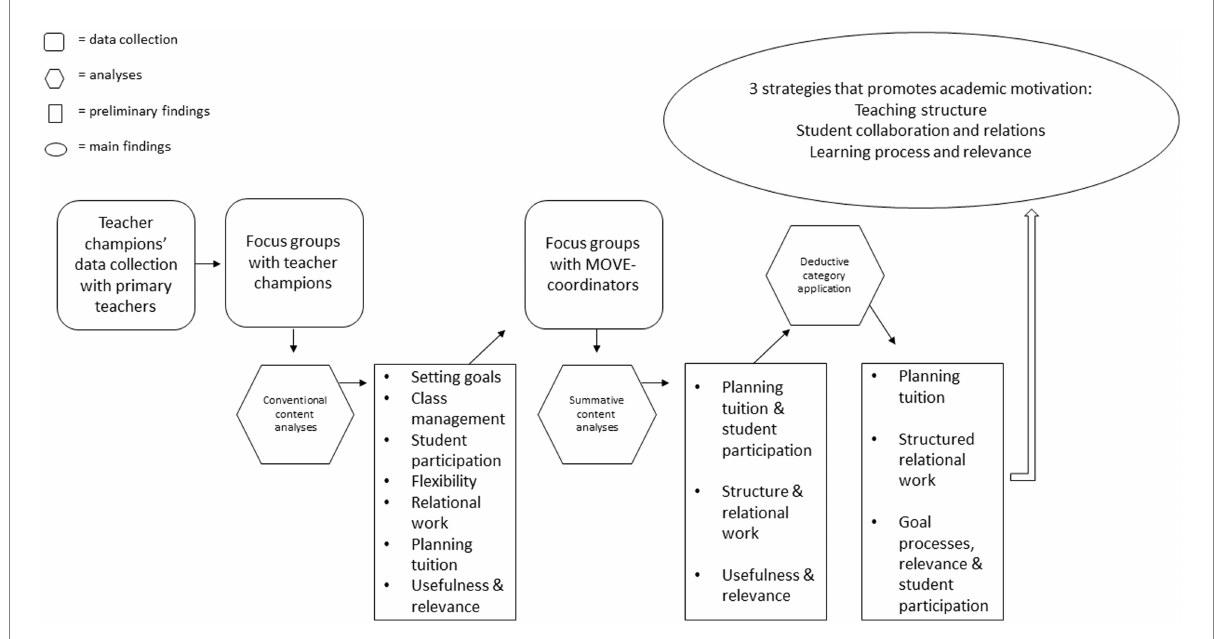
FIGURE 1 presents an overview of the data collection process, analyses, and